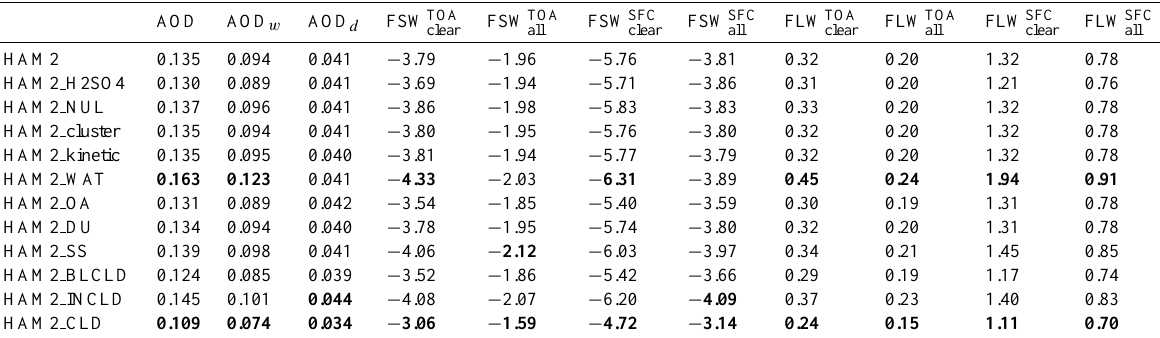
Table A3. Aerosol optical depth (AOD, unitless) and direct radiative effect (unit: W m − 2 ) in simulations discussed in this paper. AOD w and AOD d stand for the optical depth associated with aerosol water and dry mass, respectively. The radiative effect is presented in the following components: (i) top-of-atmosphere clear-sky and all-sky shortwave forcing FSW TOA and FSW TOA ; (ii) surface clear-sky and all- clear all sky shortwave forcing FSW SFC and FSW SFC ; (iii) top-of-atmosphere clear-sky and all-sky longwave forcing FLW TOA and FLW TOA ; (iv) clear all clear all surface clear-sky and all-sky longwave forcing FLW SFC and FLW SFC . Numbers given in bold are the largest and smallest values among the clear all sensitivity experiments carried out with